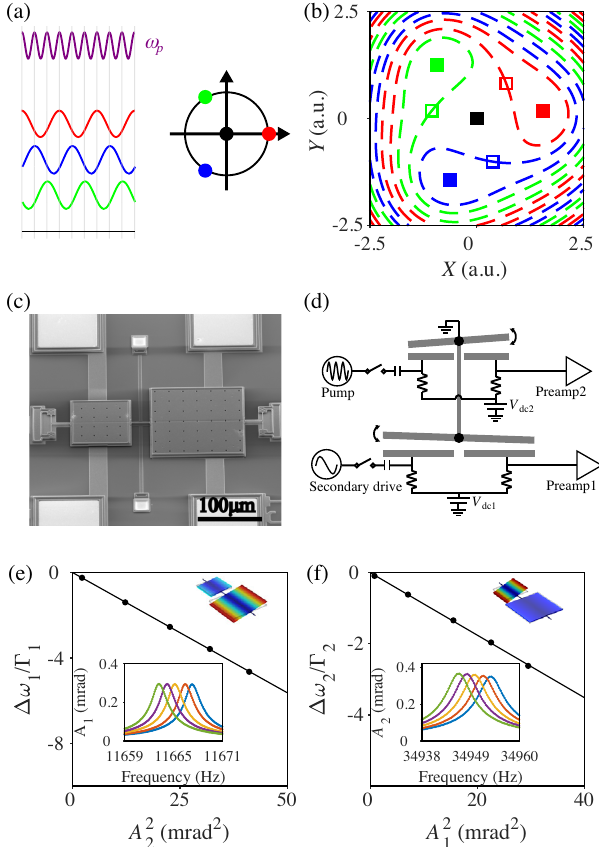
FIG. 1. (a) Periodic modulation of the cubic term in the confinement potential of a single mode at frequency ω f close to 3 ω o generates four coexisting stable states. One of them (black) is a zero-amplitude state. The other three (red, blue, and green) have identical, nonzero amplitude, with the period tripled that of the modulation. They are phase shifted by 2 π = 3 relative to one another. (b) The phase space is threefold symmetric, with four stable states shown as solid squares and the saddle points shown as hollow squares. The separatrices, represented by dashed lines, go through the latter. (c) Scanning electron micrograph of the device consisting of two suspended plates connected by a torsional rod. (d) Excitation and detection scheme (not to scale). (e) The dependence of the scaled shifts of the frequency of mode 1 on the square of the vibration amplitude A 2 of mode 2. The line is a linear fit. Lower inset: the spectra of mode 1 in response to a small periodic probe voltage for the data points in the main figure. Upper inset: the vibration profile of mode 1 involves mainly the rotations of the large plate. (f) A similar plot for mode 2 where mostly the small plate